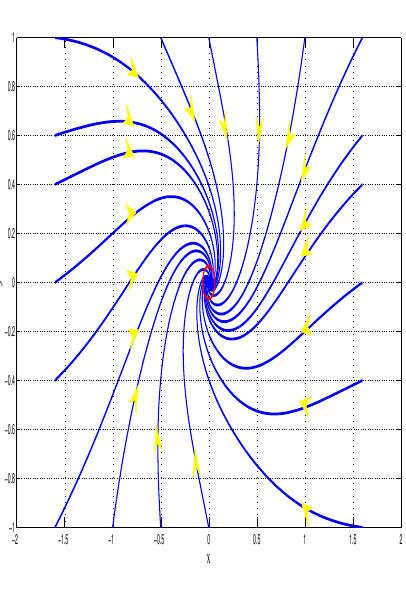
Figure 6. The numerical solutions generated by the NSFD scheme with h = 0 . 01 and t ∈ [0 , 100] in Example 4.